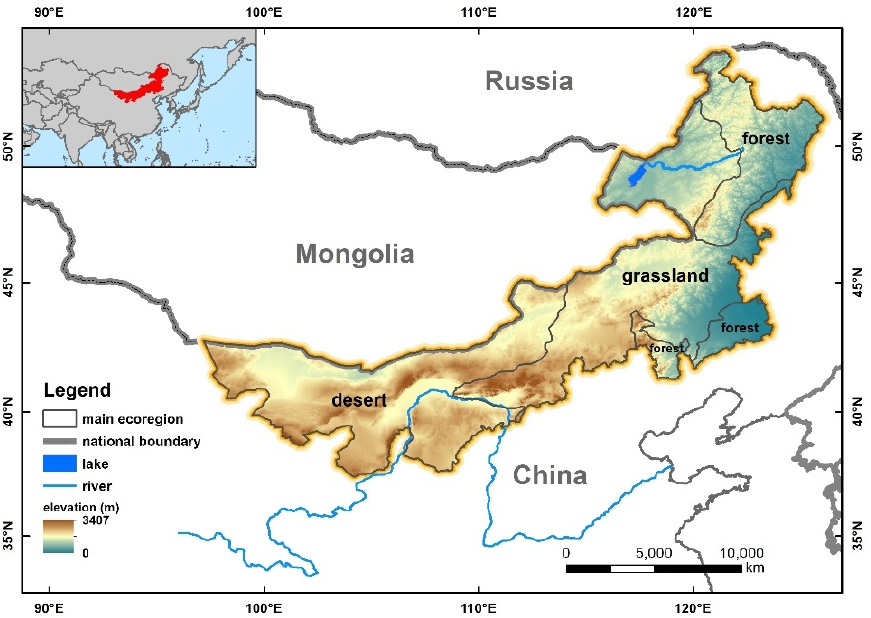
Figure 1. The study area and three major terrestrial biomes (e.g., forest, grassland, and desert). The information of biomes is derived from the WWF Terrestrial Eco-region map (available from: http://ecoregions2017.appspot.com/).